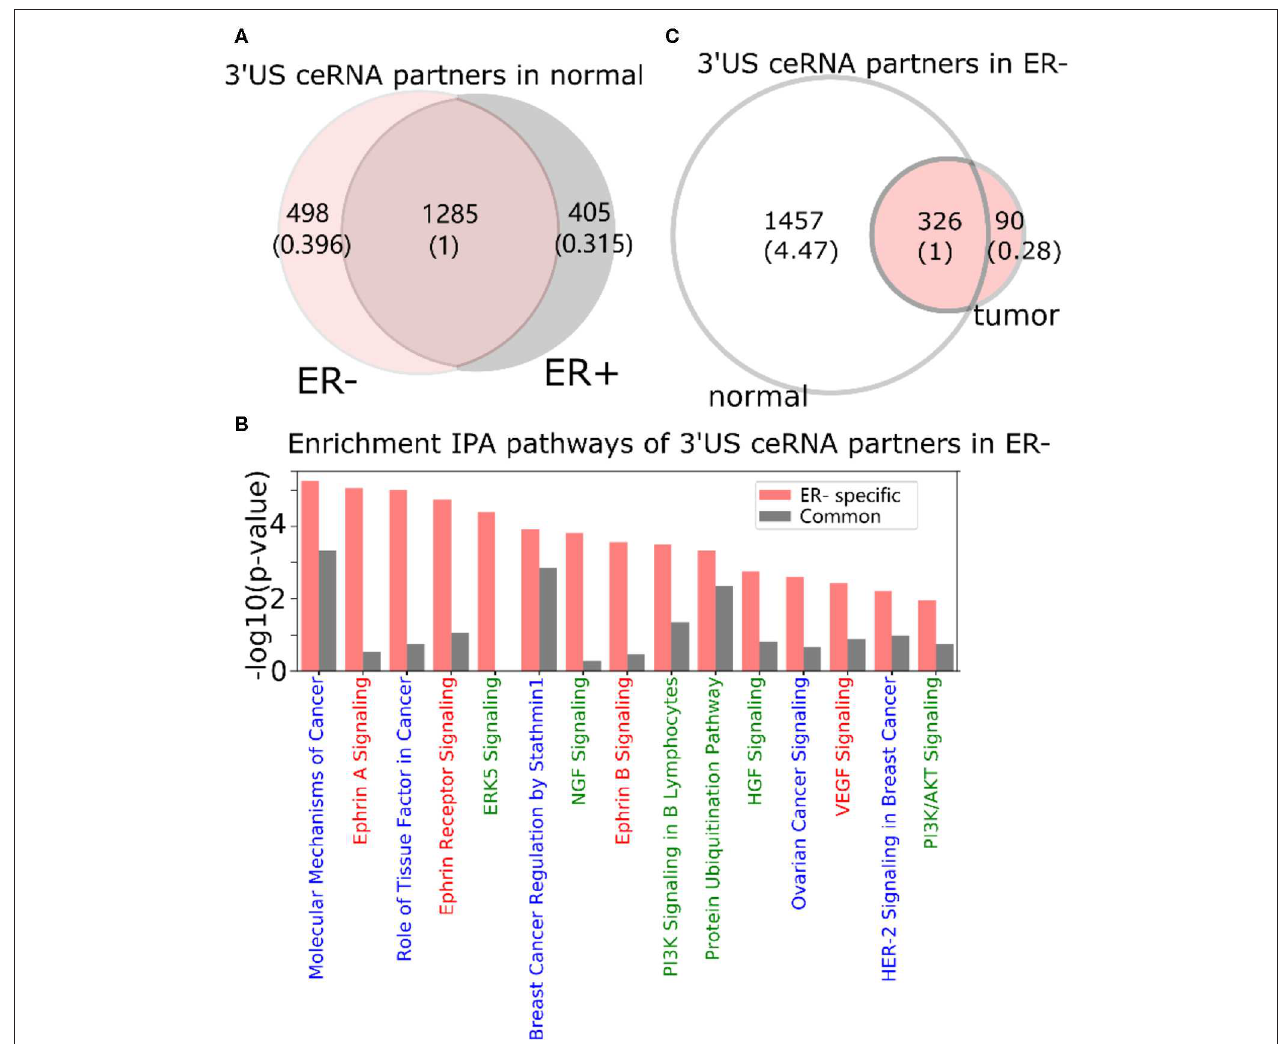
FIGURE 2 | 3 ′ UTR shortening is associated to ER-’s aggressive phenotypes in ceRNA. (A) Intersection of 3 ′ US ceRNA partners between ER- and ER ceRNA networks. (B) IPA canonical pathways significantly ( P < 0.01) enriched for the ER- 3 ′ US ceRNAs. The pathways are color-coded by keyword: “cancer” in blue, “signaling” in red, and those associated with aggressive phenotypes ( Krishnan et al., 2013) in green. (C) Intersection of 3 ′ US ceRNA partners in ER- between normal and tumor ceRNA